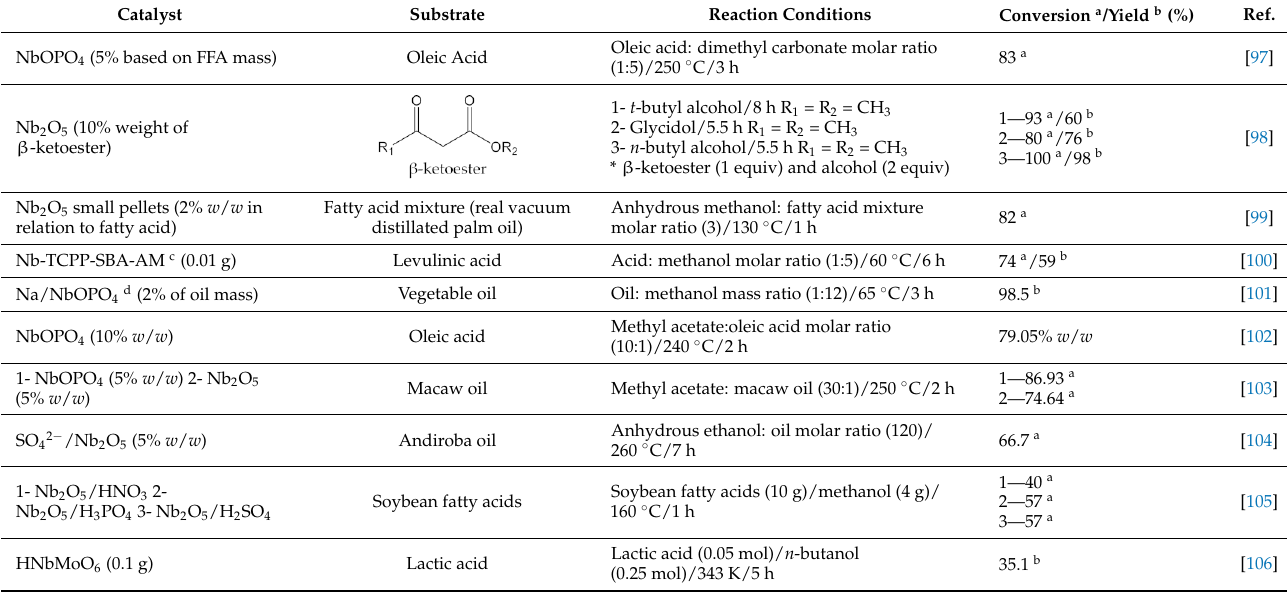
Table 2. Application of Niobium catalysts in different esterification and transesterification reactions.